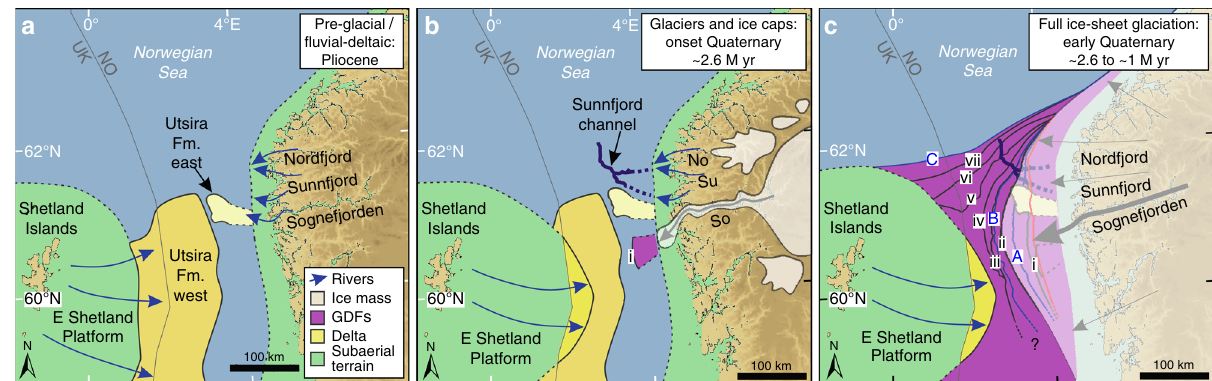
Fig. 3 Schematic models of the evolution of the northern North Sea margin during the inception of the Quaternary Ice Age. a During the Pliocene, the sand-rich Utsira Formation west accumulated at the western side of the northern North Sea Basin, fed by rivers that drained across the East Shetland Platform. A smaller delta, the Utsira Formation east, built out beyond Sognefjorden. b Around the onset of the Quaternary Period, glacigenic debris- fl ows record the fi rst advance of grounded ice to the palaeo-shelf break beyond Sognefjorden. Sunnfjord channel was probably formed during this time, and an early Quaternary fl uvial delta built out beyond the East Shetland Platform 14 . c During the early Quaternary, the northern North Sea Basin was in fi lled by sediments derived from an ice sheet over southern Norway. The geometry of the clinoform units shows that the Sognefjorden area continued to be the dominant pathway for the transport of glacial sediments to the northern North Sea through the early Quaternary. A delta, fed by rivers that crossed the East Shetland Platform, continued to build up at the western side of the northern North Sea Basin. Topography colours and labels are the same as in Fig. 1. GDF = glacigenic debris- fl